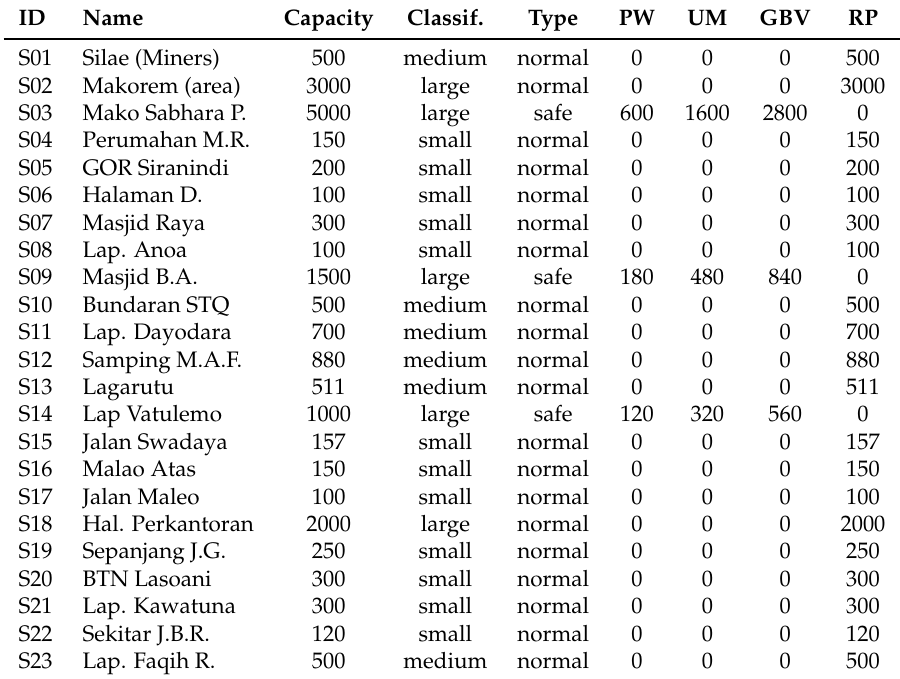
Table 4. Shelter characteristics and capacity distributions. PW: pregnant women. UM: unaccompanied minors. GBV: women susceptible to gender violence. RP: rest of the